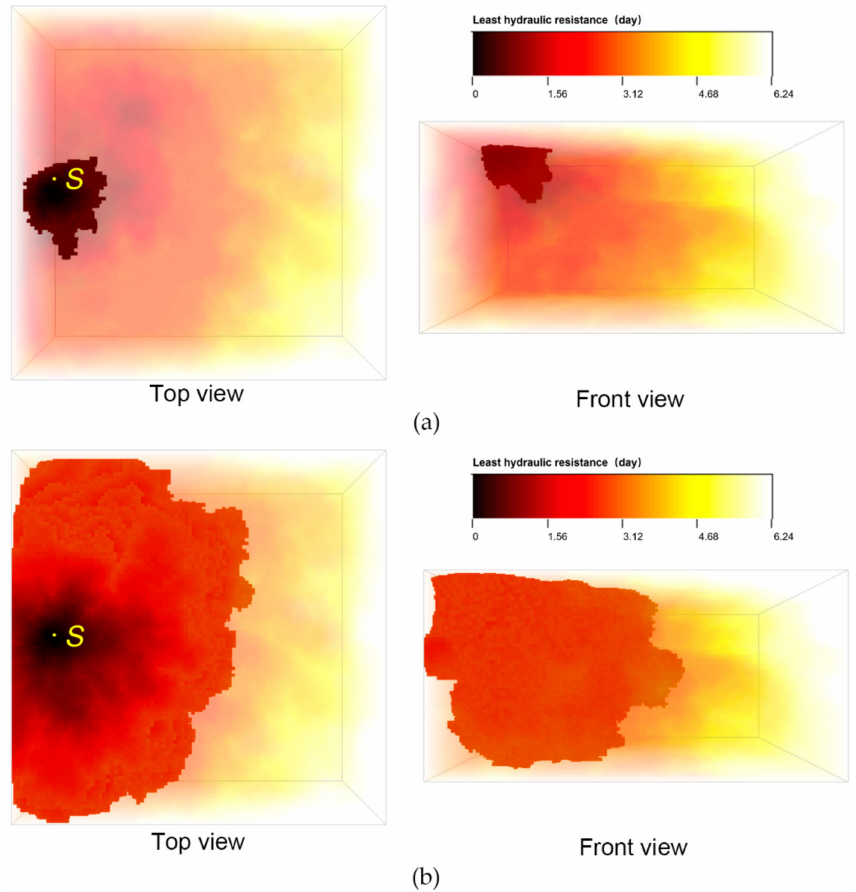
Figure 13. Calculation of minimum hydraulic resistance (i.e., the minimum number of days required for a solute to reach a voxel from initial voxel S). Reachable regions by ( a ) the first day and ( b ) the third